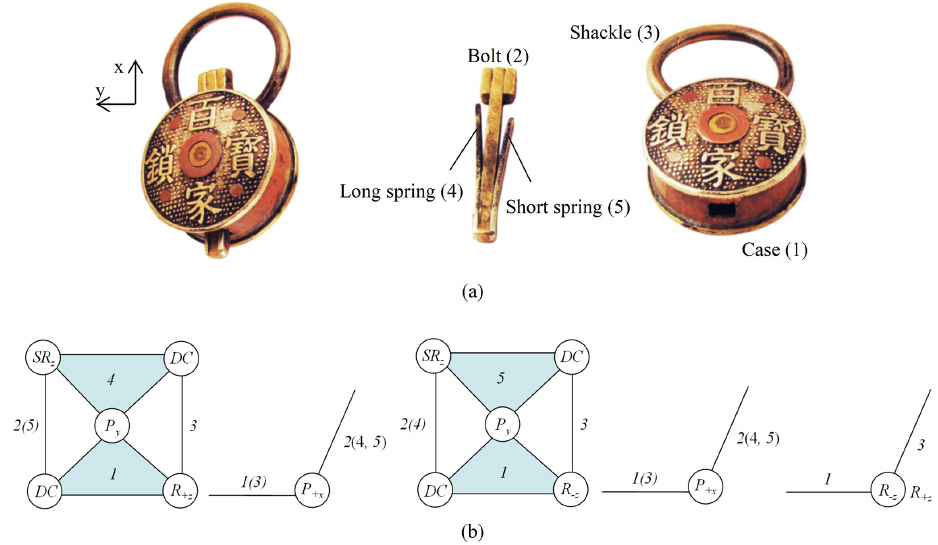
Figure 10. Copper padlock with pressing shackle – keyless lock (Yi Zhi Tang